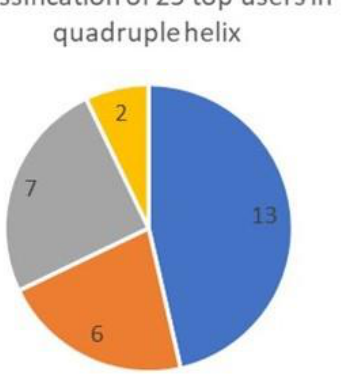
Figure 5. Classification of 25 top users in quadruple helix, with two people having a double function “ academia ” and chart excluding